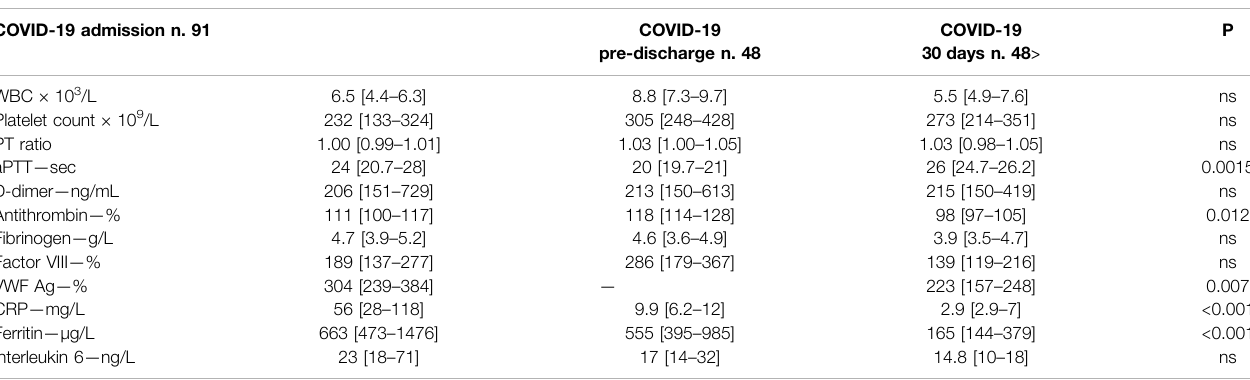
TABLE 2 | Laboratory fi ndings in the study population.